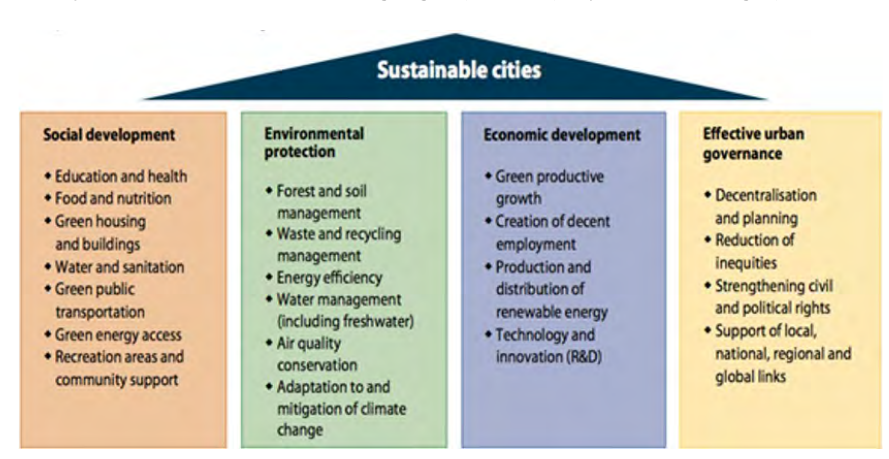
Figure 1. Sustainable Cities (Pisano, Lepuschitz & Berger,